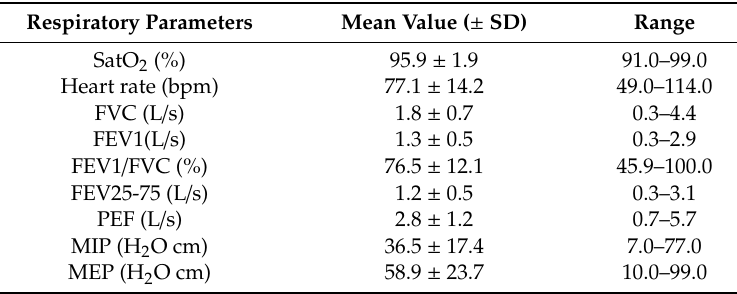
Table 2. Respiratory function